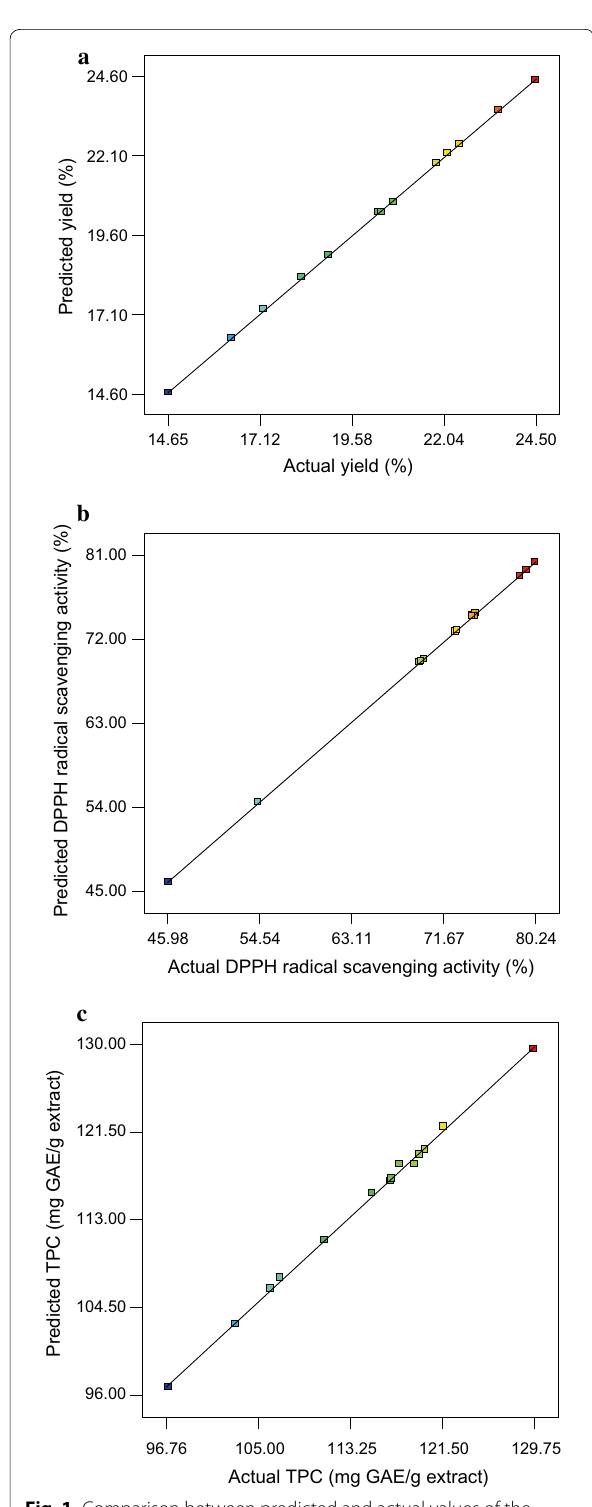
Fig. 1 Comparison between predicted and actual values of the response variables a extraction yield b DPPH radical scavenging activity and c TPC of C. nutans